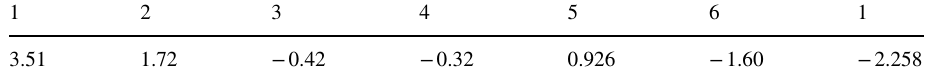
Table 5 Constants of the ANN model